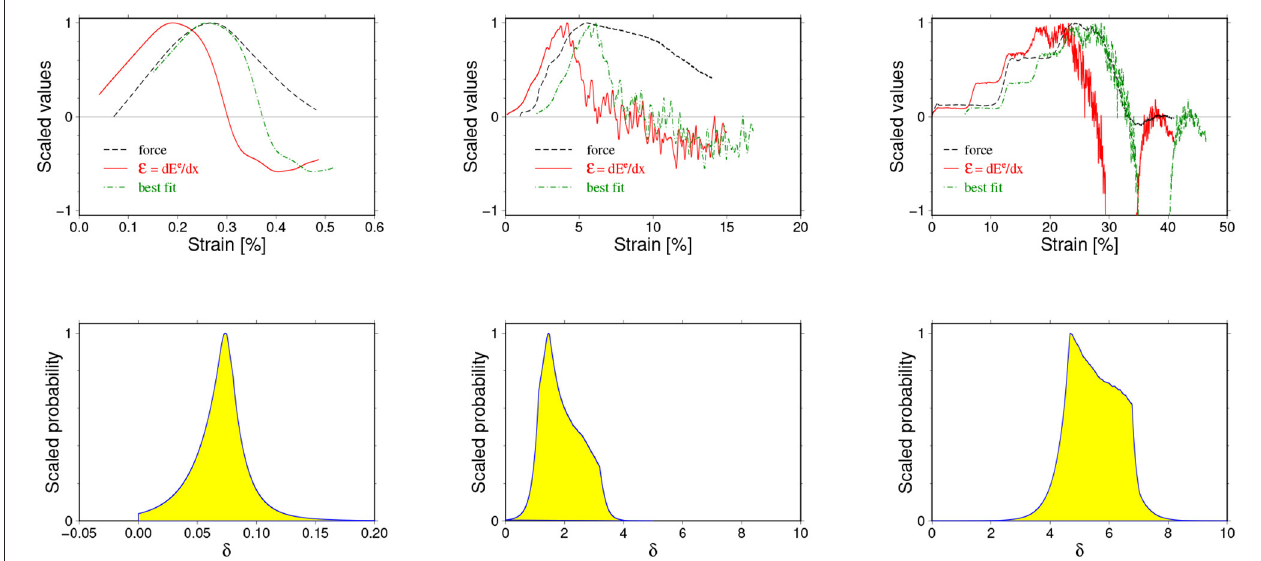
FIGURE 5 | Three examples of an estimation of the delay parameter δ x using the Bayesian (probabilistic) approach. The curves F ( x ), E ( x ), and E ( x + δ x ) for the optimal δ x value are shown in the upper row. The lower row shows corresponding a posteriori probability distributions. The shown cases correspond to one of the best (almost noise-free) simulation results (left column) with well matching F and E curves, a typical situation (middle column) and a “difficult” case when acoustic waves strongly disturbed the breaking